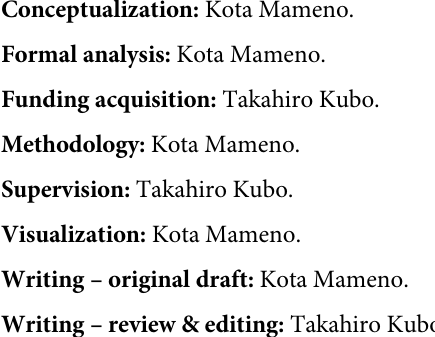
S2 Table. Estimation results in various favored